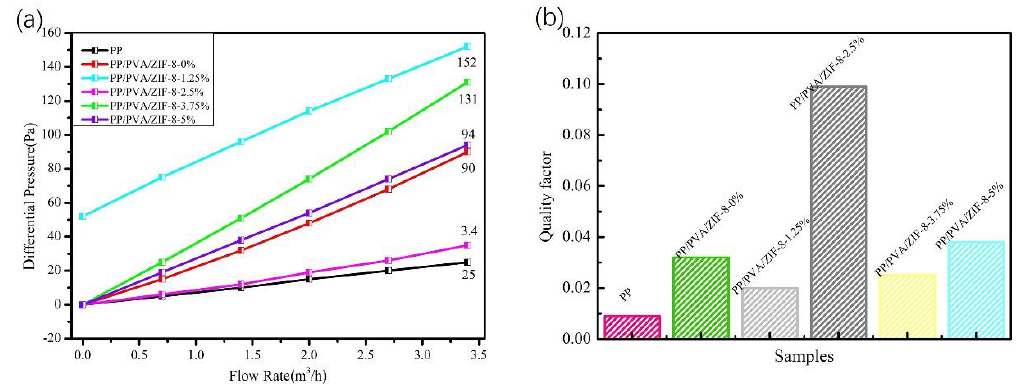
Figure 8. ( a ) Pressure drop resistance and ( b ) quality factor of membranes in relation to DEHS aerosol of 0.218–2.478 µm.